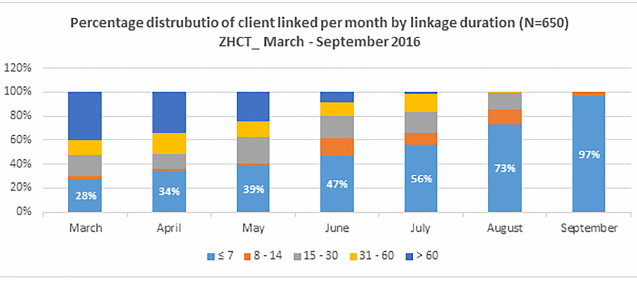
Fig 2. Percentage distribution of clients linked per month within ZHCT by time it took to complete linkage.